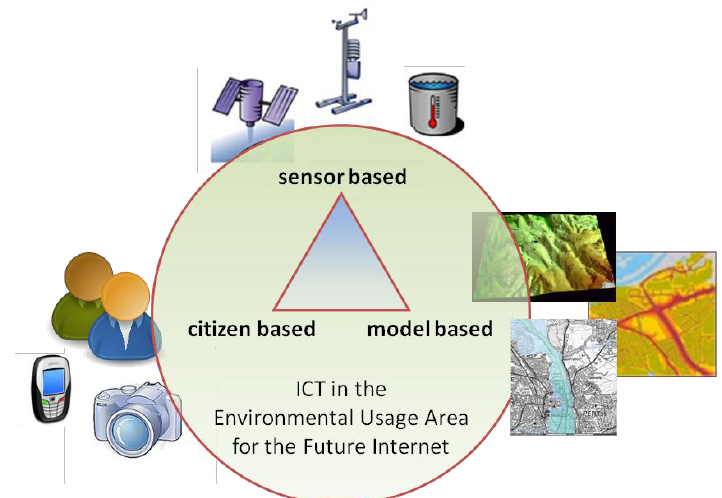
Figure 4. Technology triangle: observations from sensors, humans and